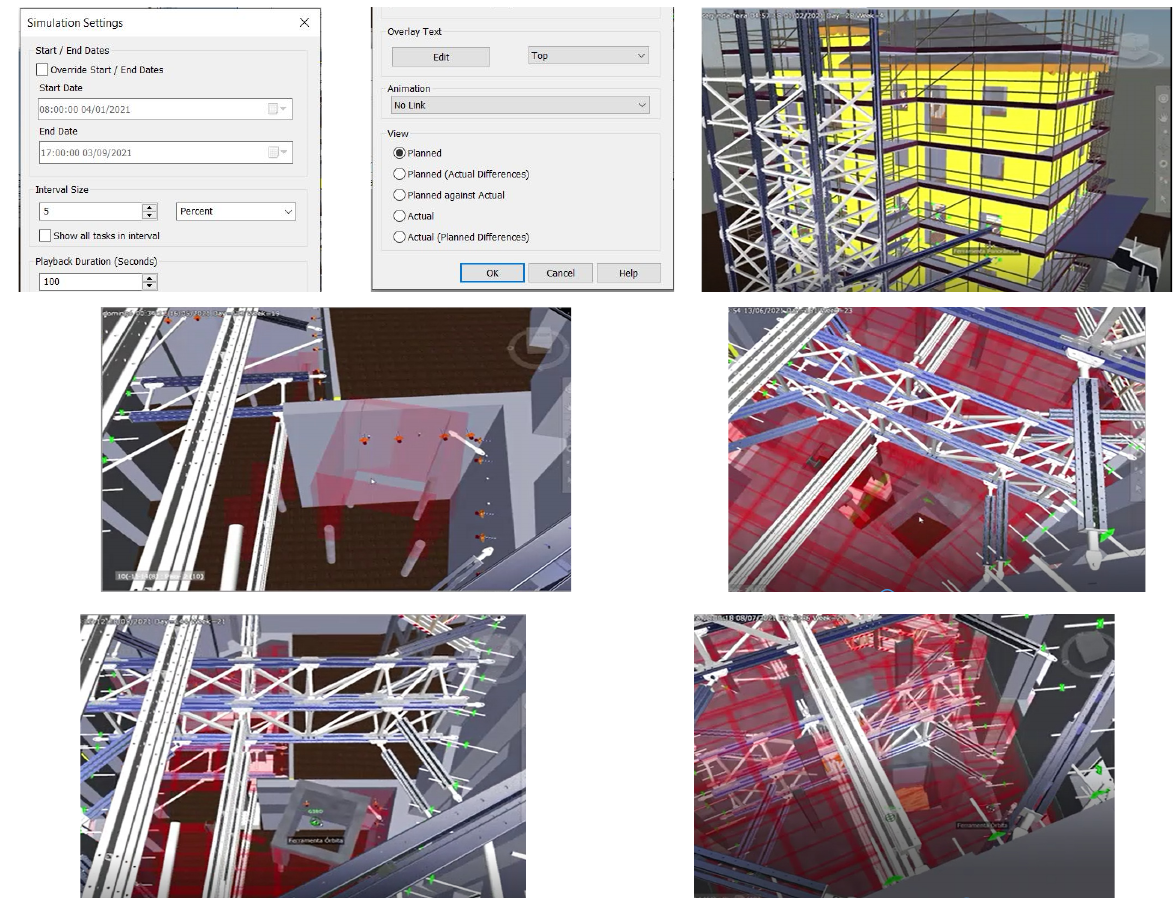
Figure 24. Simulation of construction progress of definitive and temporary elements.